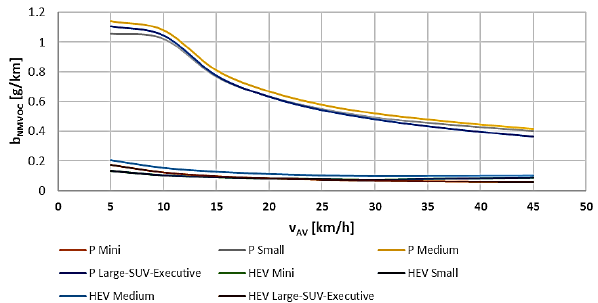
Fig. 24. NMVOC emission from petrol PCs for vehicle segments depending on average speed